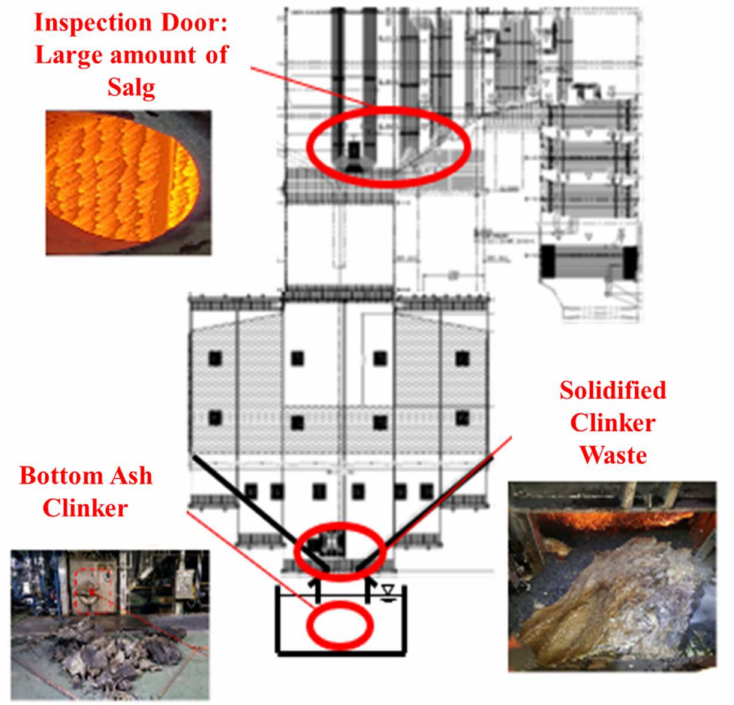
Figure 1. Illustration of clinker and high-temperature corrosion issues associated with biomass